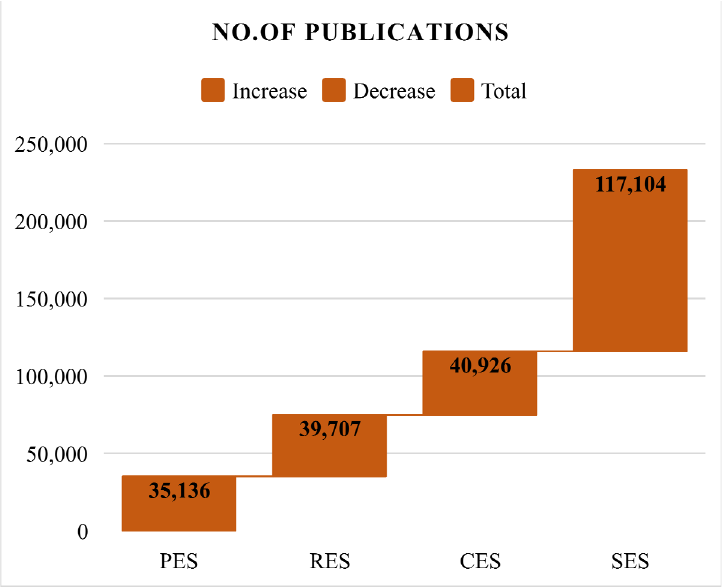
Figure 3. Number of publications on ecosystem services classification—chronology. Where PES in- dicates provisioning ecosystem services, RES is regulating ecosystem services, CES is cultural eco- system services and SES is supporting ecosystem services.